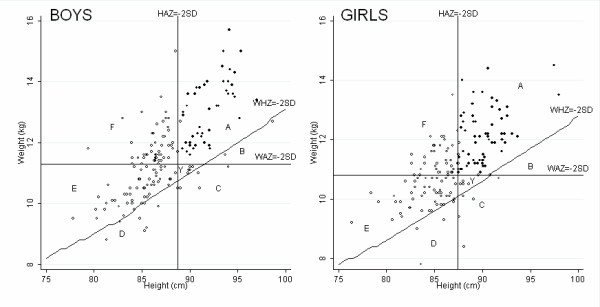
Distribution of growth faltering at 36 months of age according to WHO growth standards. Key- A: Not malnourished, B: Wasted only, C: Wasted and underweight, D: Wasted, stunted and underweight, E: Stunted and underweight, F: Stunted only, Y: Underweight only. Open circles denote children with at least one growth faltering, closed circles denote children with normal growth.